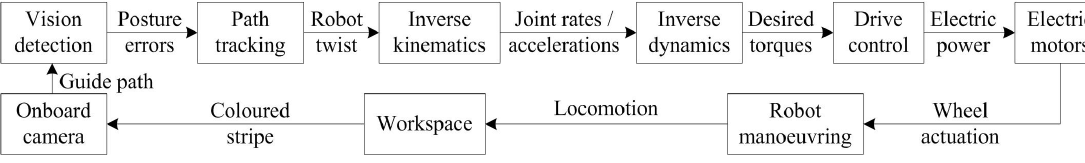
Figure 4. A closed-loop receding-horizon control